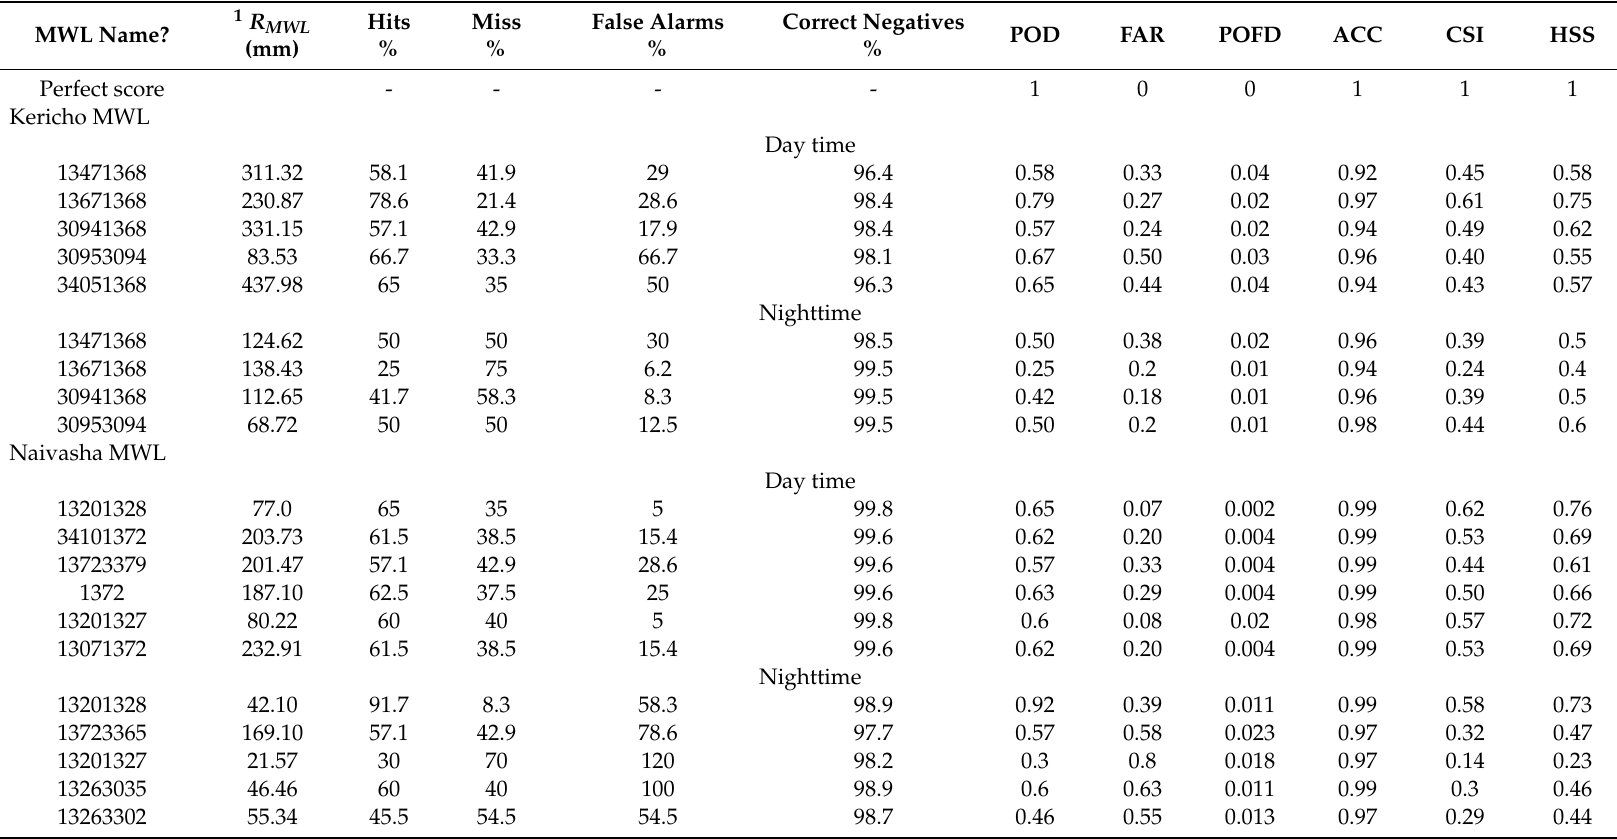
Table 7. Computed performance verification scores of rain detection using MWL and MSG